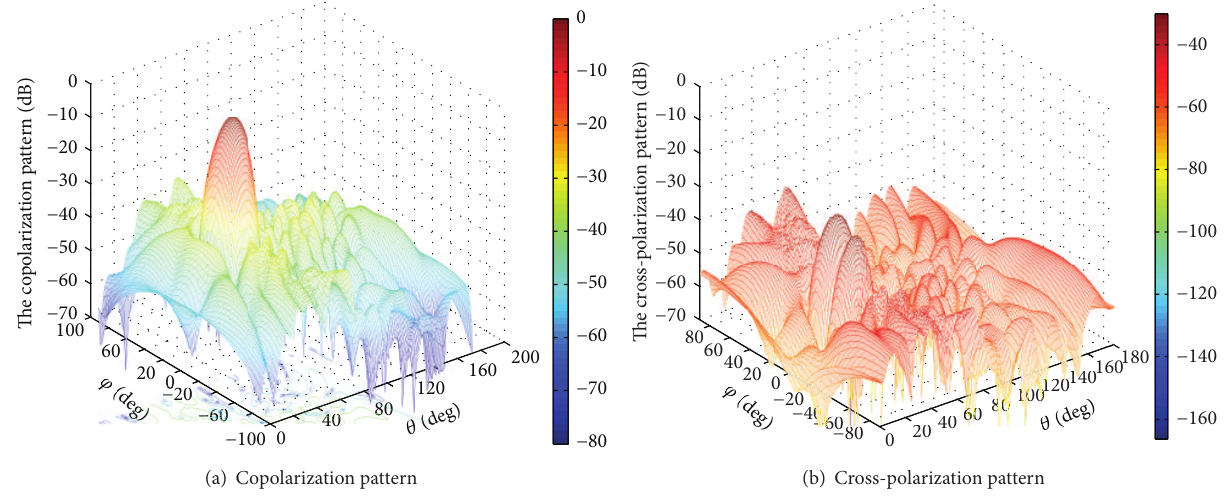
Figure 12: 3D radiation pattern of the conical conformal array for scan direction of (45 ∘ , 0 ∘ ) for solution A in Figure